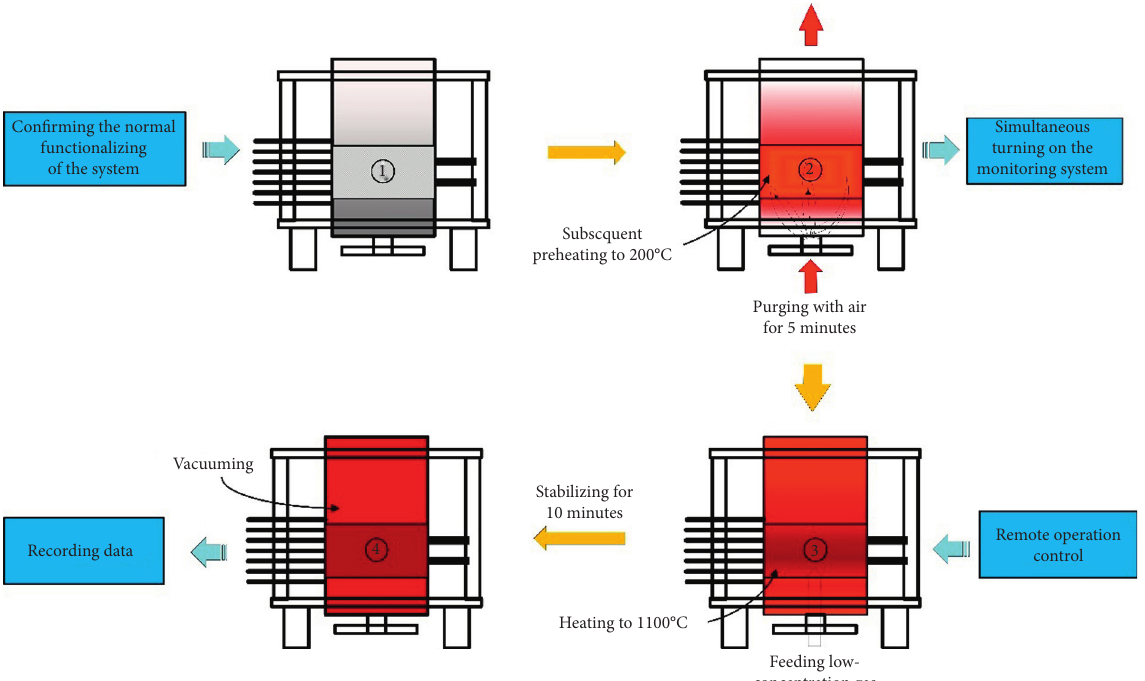
Figure 5: Operation steps of temperature rise test